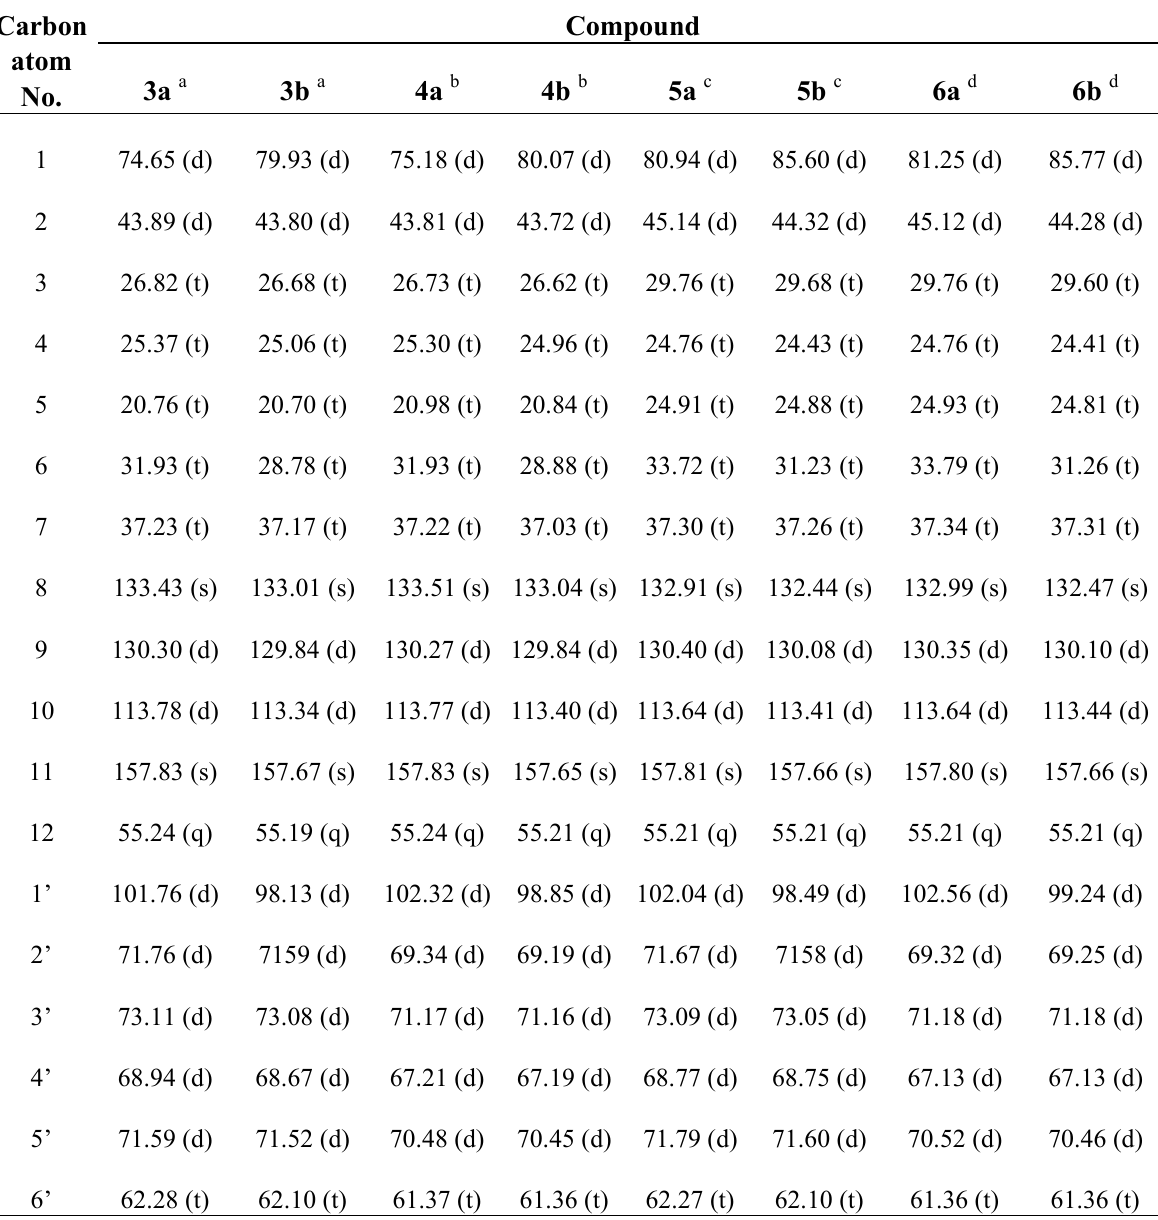
Table 1 . 13 C-NMR data of the protected alkyl glycosides 3a – 6b (measured in CDCl